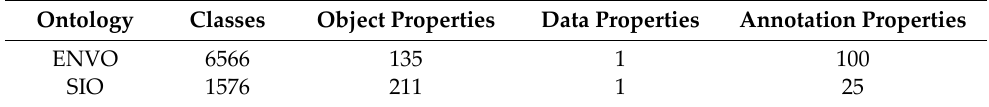
Table 2. Information on related ontologies.